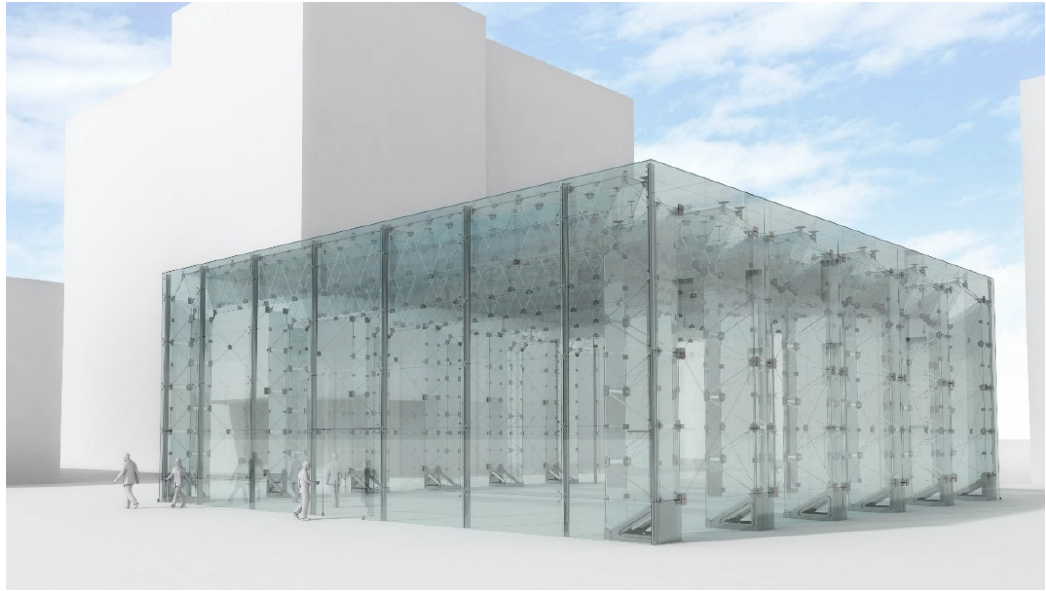
Figure 3. Rendering image of the Travi Vitree Tensegrity (TVT) Pavilion.